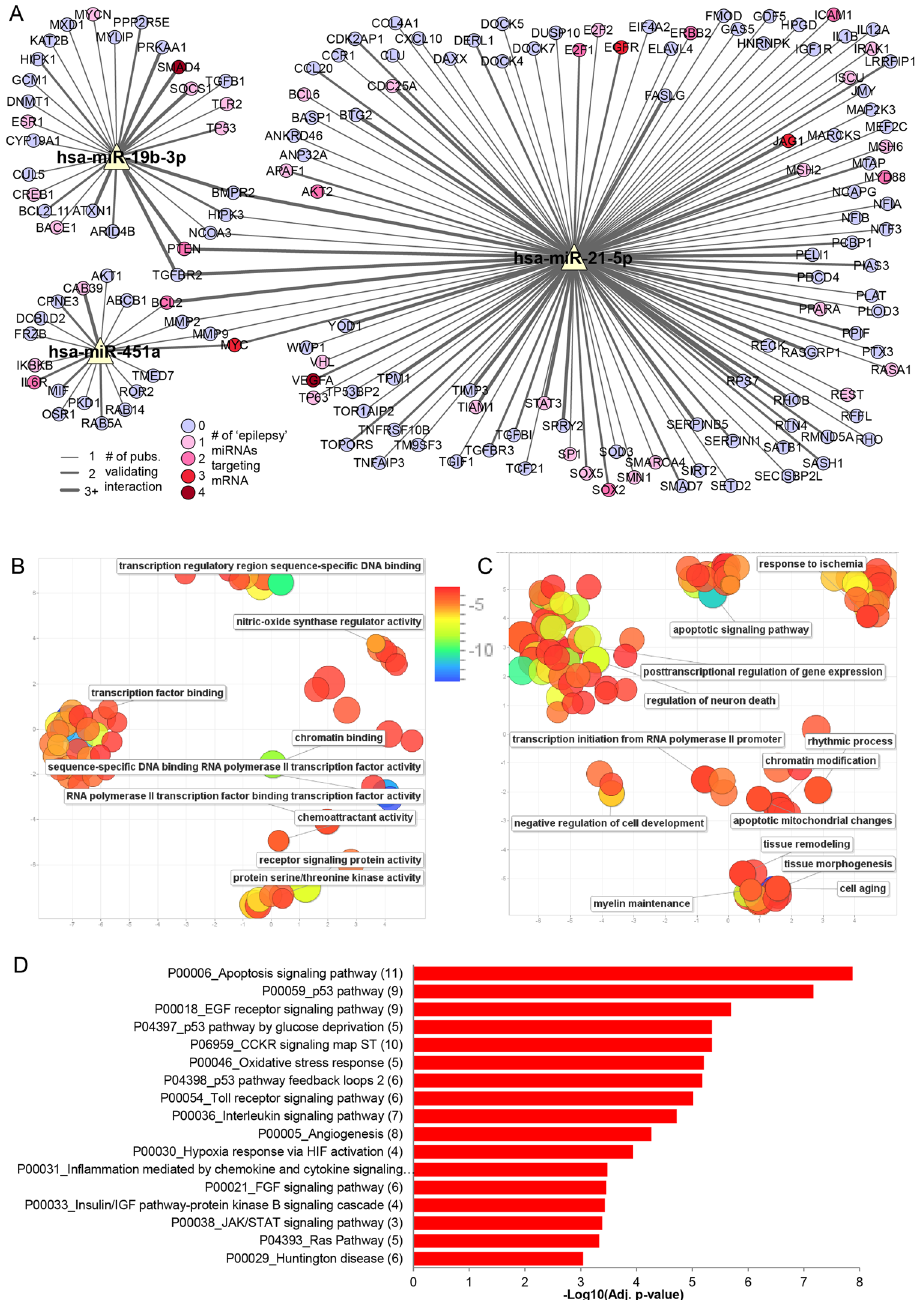
Figure 7. MicroRNA target prediction and pathway enrichment analysis. ( A ) MicroRNA-Target Interaction Network showing targets with strong experimental evidence from miRTarBase for miR-19b-3p, miR-21-5p and miR-451a. Edge thickness corresponds to the number of publications that validated the miRNA-mRNA interaction. Pink/red coloured targets are also targets of one or more of the functionally-validated epilepsy- associated microRNAs (see Materials & Methods). The network was generated using Cytoscape software. ( B , C ) Removal of GO term redundancy and semantic visualisation of the significantly associated GO molecular function ( B ) and biological processes ( C ) (adjusted p -value < 0.05) using REVIGO. The scatterplot shows the cluster representatives (i.e. terms remaining after the redundancy reduction) in a two dimensional space derived by applying multidimensional scaling to a matrix of the GO terms’ semantic similarities (the axes have no intrinsic meaning). Bubble colour indicates the log 10 (adjusted p -value) (legend in upper right-hand corner of B ); size indicates the frequency of the GO term in the underlying Homo sapiens database (bubbles of more general terms are larger). ( D ) Bar plot showing the − log 10 (adjusted p -value) of significantly enriched (adjusted p -value < 0.001) PANTHER pathways for validated targets of miR-19b-3p, miR-21-5p and miR-451a. The number of targets in a given pathway is shown in